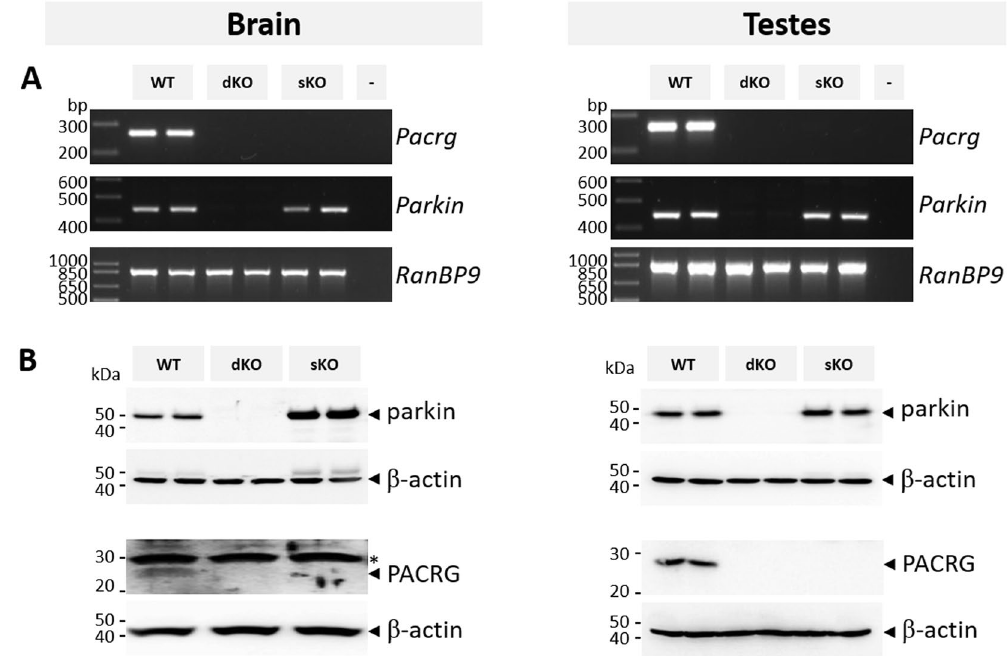
Figure 2. Knockout mice do not express protein from the deleted locus. ( A ) Total RNA from the brain and testes (n = 4/genotype) were assessed for expression of parkin and Pacrg . Expression of parkin and pacrg was not detected in the double parkin-Pacrg knockout (dKO), and expression of Pacrg was not detected in the single Pacrg knockout (sKO) but the full length transcripts were detected in wildtype (WT) tissues. Amplification of mRNA from the unrelated gene encoding RAN binding protein 9 ( RanBP9 ) was performed in parallel to confirm RNA integrity. ( B ) Whole protein lysates from the brain and testes (n ≥ 3/genotype) were used to investigate steady-state parkin and PACRG levels in WT, dKO and sKO mice. Western blot analysis using an anti-parkin antibody detected parkin in WT and sKO tissues but not in dKO tissues, while an anti-PACRG antibody detected PACRG only in the WT tissue. The membranes were reprobed with an anti- β -Actin antibody to confirm protein integrity and equivalent loading. * Non-specific